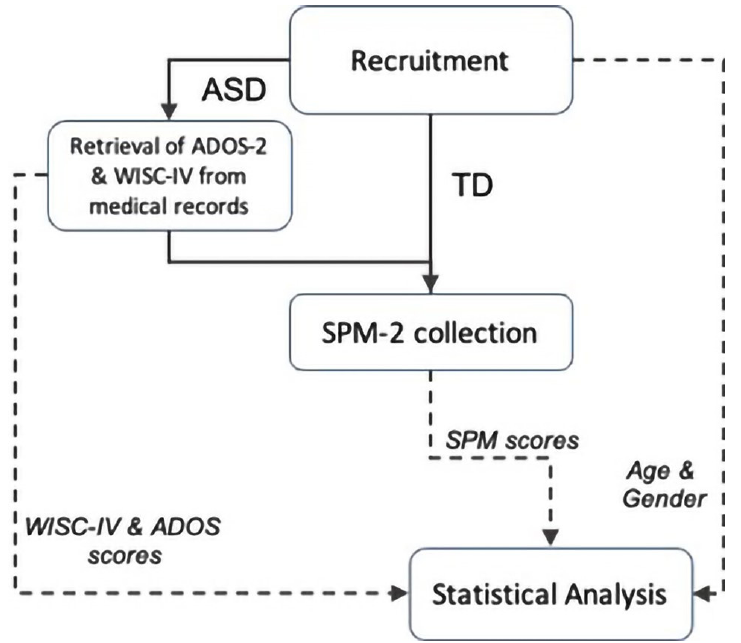
Figure 1. Workflow of the study. Boxes refer to the procedures performed by experimenters. Solid arrows indicate the connection between boxes; the dashed arrows connect the box where an input is generated with the box where that input is used.